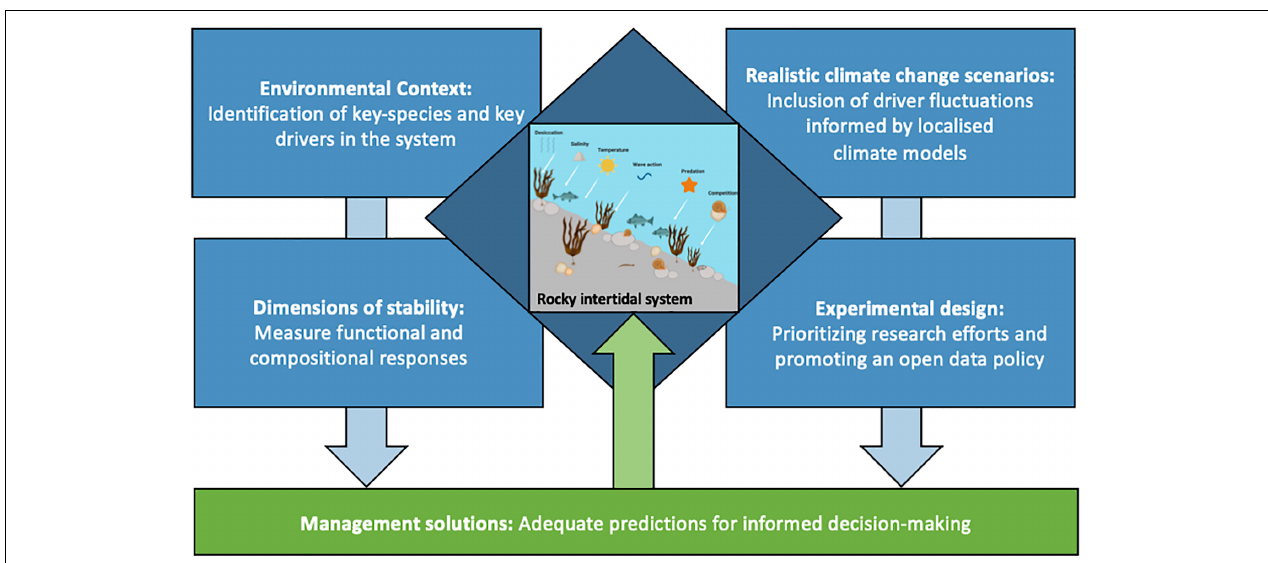
FIGURE 3 | An integrated approach for rocky intertidal systems, which should consider environmental context, realistic climate change scenarios, dimensions of stability and experimental design. Findings from the four areas combined can support improving management solutions toward conservation and sustainable use of rocky intertidal